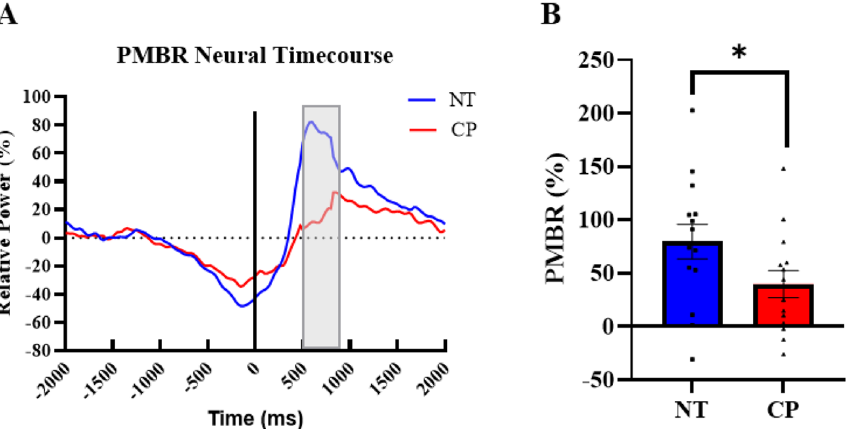
Figure 5. PMBR neural timecourse ( A ) Neural timecourses of the PMBR response in individuals with CP (red) and the NT group (blue) extracted from the peak voxel of the PMBR. The black line at 0.0 ms denotes movement onset, and the gray box is the window of interest (500 to 800 ms). ( B ) Bar graph depicting the difference in PMBR strength between the NT and CP groups. Overall, those with CP had a weaker PMBR compared to controls. *P <